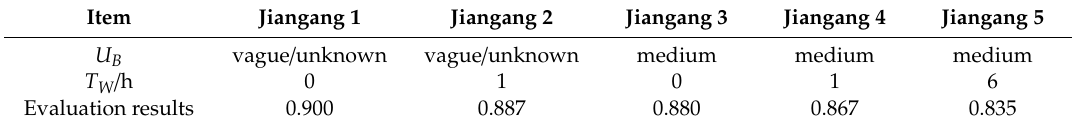
Table 6. Potential loss of life of Jiangang Reservoir dam breach under five conditions.